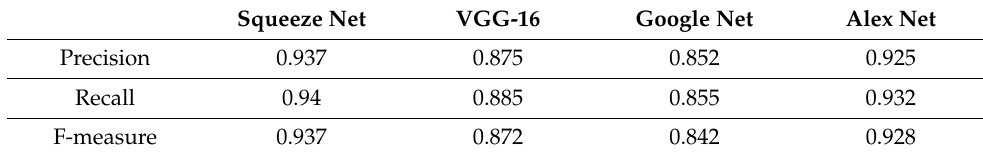
Table 4. Precision, Recall, and F-measure of DL Networks for SSA space debris detection.